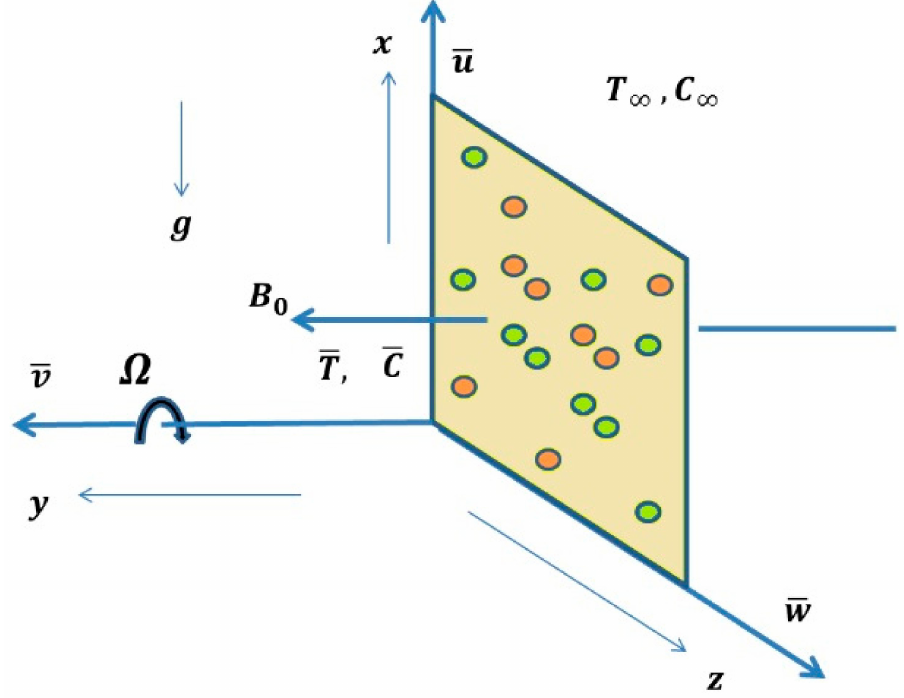
Figure 1. The coordinate system and schematic diagram of the